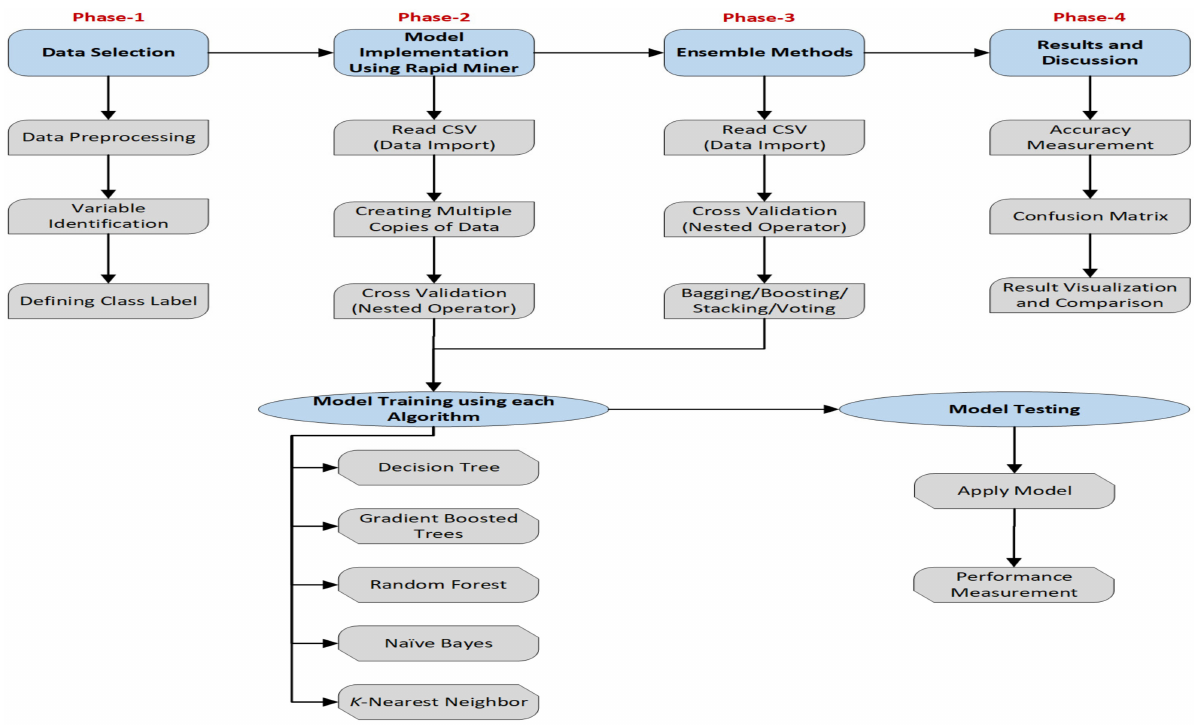
Figure 1. Proposed framework for intelligent decision support system using an ML